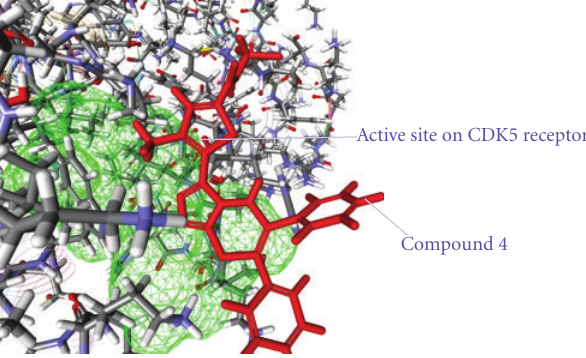
Figure 5: The docked conformation of compound 4 with the receptor CDK5/p25 (PDB: 3O0G). Compound 4 is indicated by red color while the most active site of the CDK5 receptor is shown with green color.